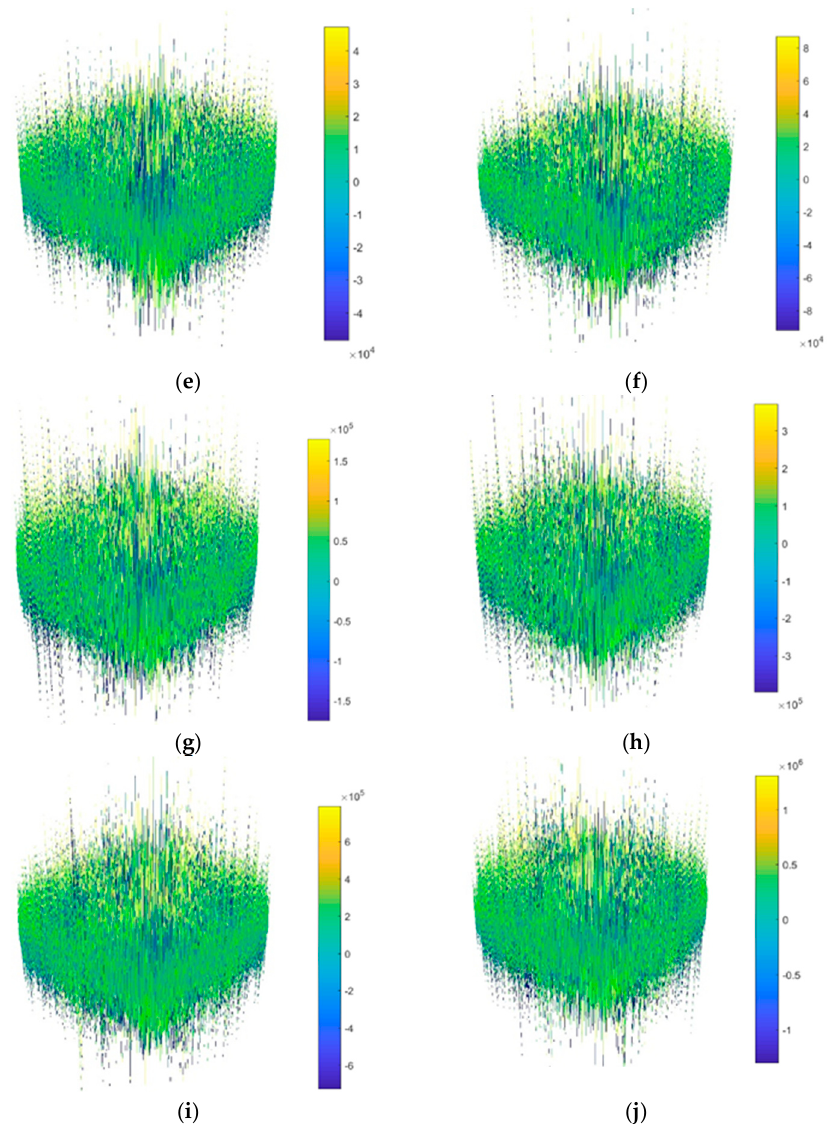
Figure 11. Three-dimensional images of encrypted DEM B. The numbering sequence is consistent with the encryption round.